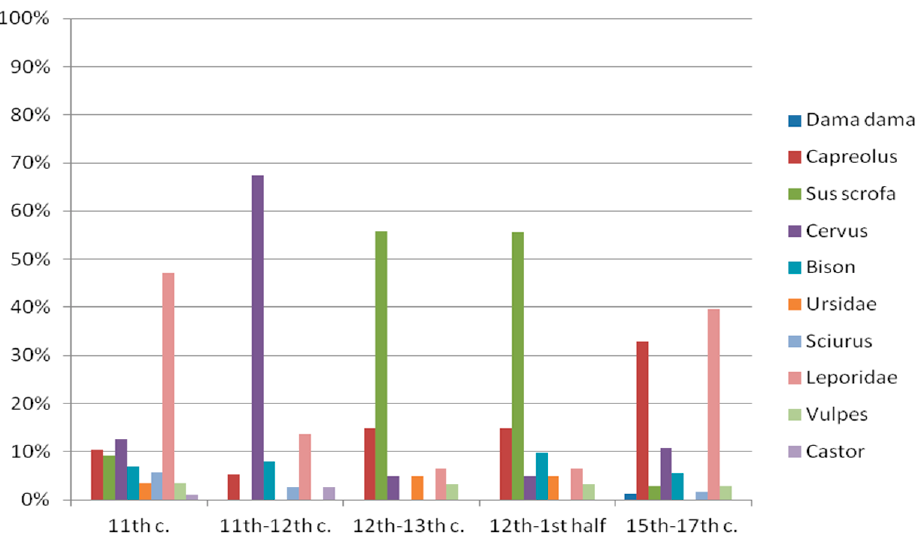
75% 80% 85% 90% 95% Figure 2. The bones of individual groups of animals present in medieval and modern Wrocław according to results of the discussed archaeozoological research [1,29–32]. Description: M. Pietruszka. Research was also conducted at a site located at 4–6 Ś w. Idziego Street at Ostrów Tumski (dig site no. IIIF). The material was split into two phases, the first one dated 10th– 11th c; however, the layers dated for the 10th c. contained remains of only domesticated animals. The second phase is dated from the 12th to the first half of the 13th c.—the condition of the remains allowed for ca. 54% (8371 fragments) to be identified. In phase I, wild mammals constituted 1.5% of the identified material, mostly represented by hare bones, followed by red deer, roe deer, boar, wisent, squirrel, fox, bear and beaver. In the case of phase II, there was a slight increase in the material from wild animals: 2.2%. Bones of boar, roe deer, wisent, hare, bear, red deer and fox were found, with boar bones constituting over half of the assemblage (Figures 2 and 3) [30].